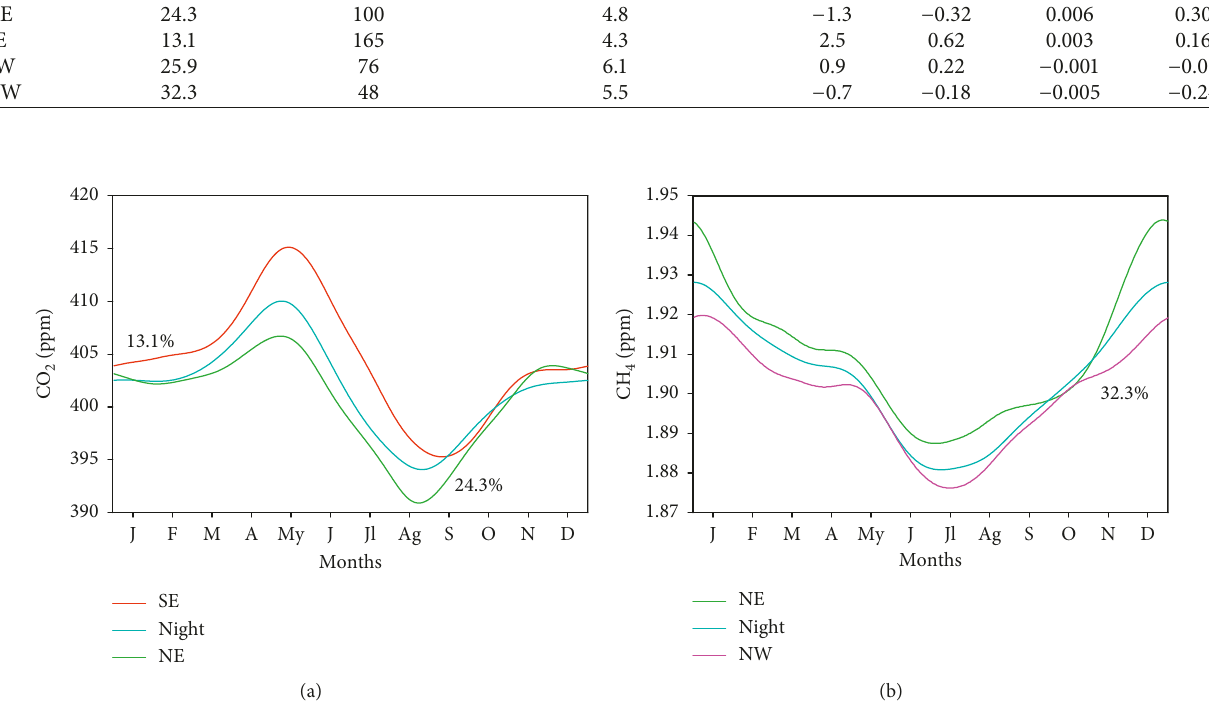
Figure 5: Annual evolution of CO 2 (a) and CH 4 (b) during the night (cyan line) together with the evolution for the trajectory centroid direction of prominent quadrants (red, green, and purple lines). The appearance frequency of each direction is also